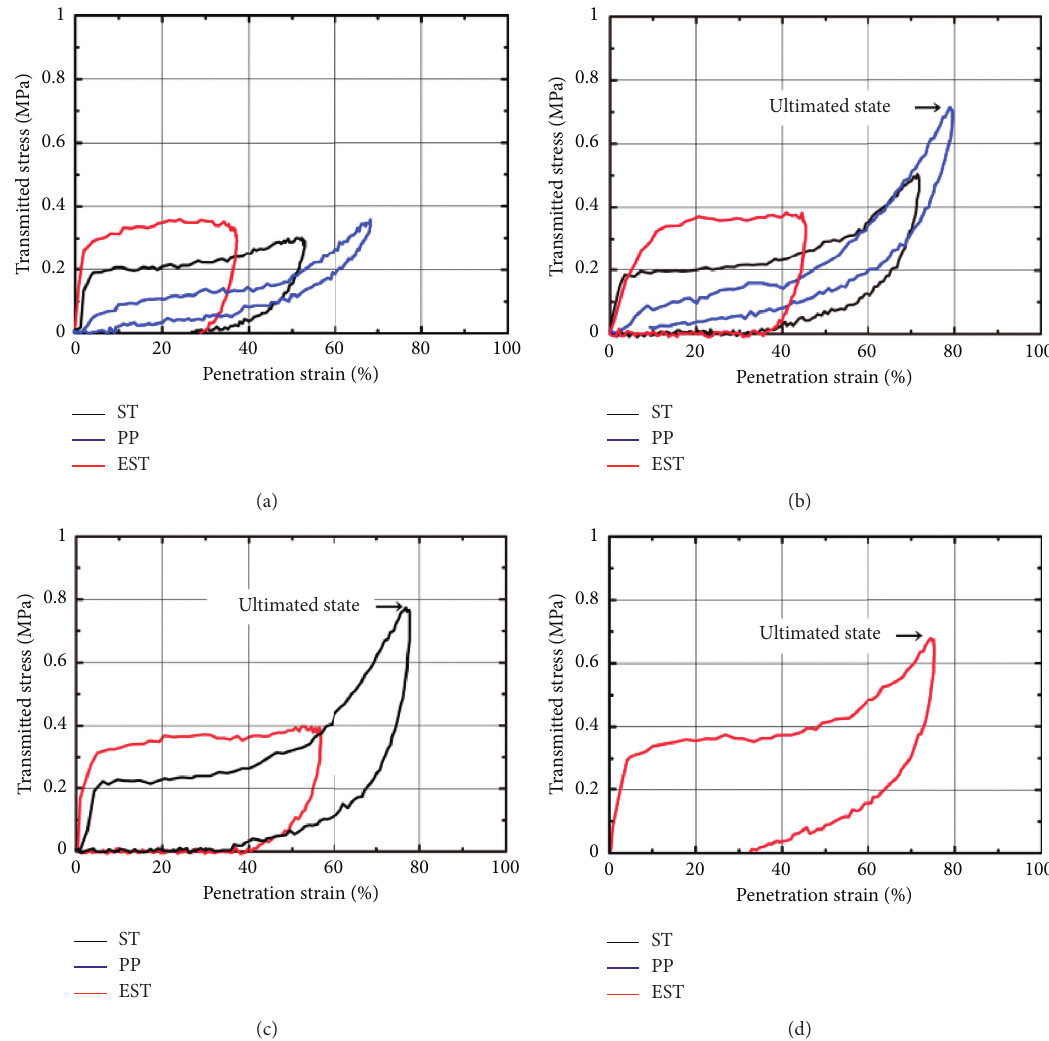
Figure 8: Transmission impact stress-penetration distortion hysteresis loop for materials without a core slab. (a) H � 100mm. (b) H � 150mm. (c) H � 200 mm. (d) H � 300mm.